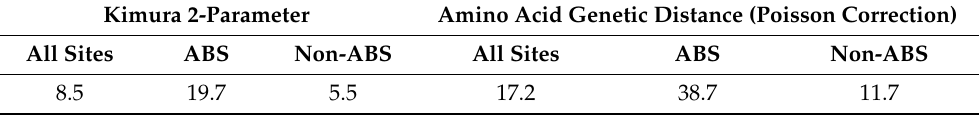
The Kimura 2-parameter nucleotide genetic distance between the seven alleles ranged from 0.012 to 0.161. The genetic distance of amino acids ranged from 0.012 to 0.334 (corrected by Poisson). The variation in the amino acid residues ranged from 1 (1.25%) to 15 (18.75%). The genetic distance between the gene antigen binding sites and non-antigen binding sites is shown in Table 4. Table 4. The average nucleotide and amino acid distances among the Przewalski’s horse MHC DQA alleles. Kimura 2-Parameter Amino Acid Genetic Distance (Poisson Correction) All Sites ABS Non-ABS All Sites ABS Non-ABS 8.5 19.7 5.5 17.2 38.7 11.7 The neighbor-joining tree was constructed using our identified DQA allele sequences of Przewalskl’s horses, by combing nine other equine sequences published in the litera- ture. It could be observed from the phylogenetics tree that ELA-DQA2 and ELA-DQA3 in Przewalski’s horses clustered together, but separated from ELA-DQA5 and ELA-DQA6. ELA-DQA1 and ELA-DQA7 belonged to another branch (Figure 2). The phylogenetic relationship between zebras and domestic horses was not as close as that between Przewal- ski’s horses and domestic horses. Domestic horses were closer to the tree roots than other equine animals.